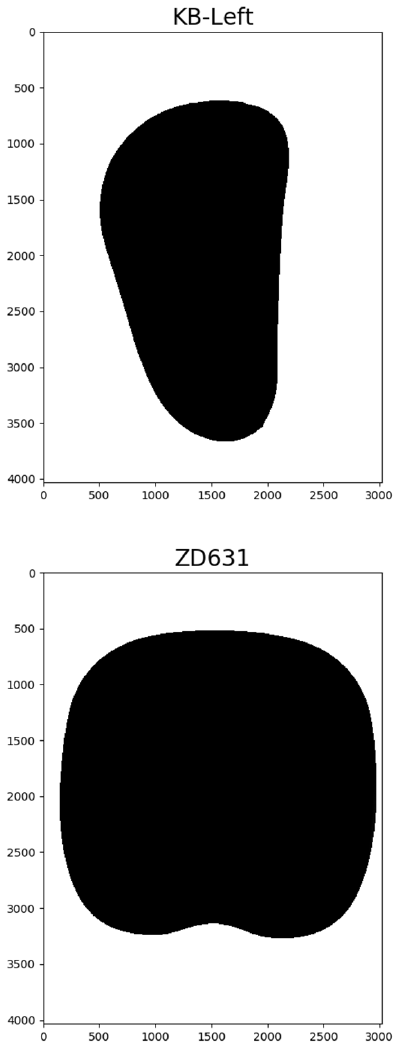
Figure 6. Sub-template work piece database.